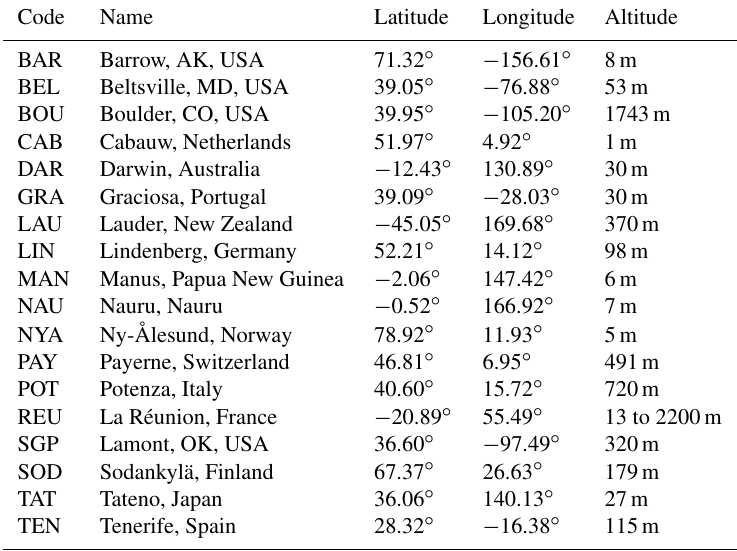
Table A1. Details of GRUAN sites used by this study. Station information has been taken from https://www.gruan.org/network/sites (last access: 29 October 2021).